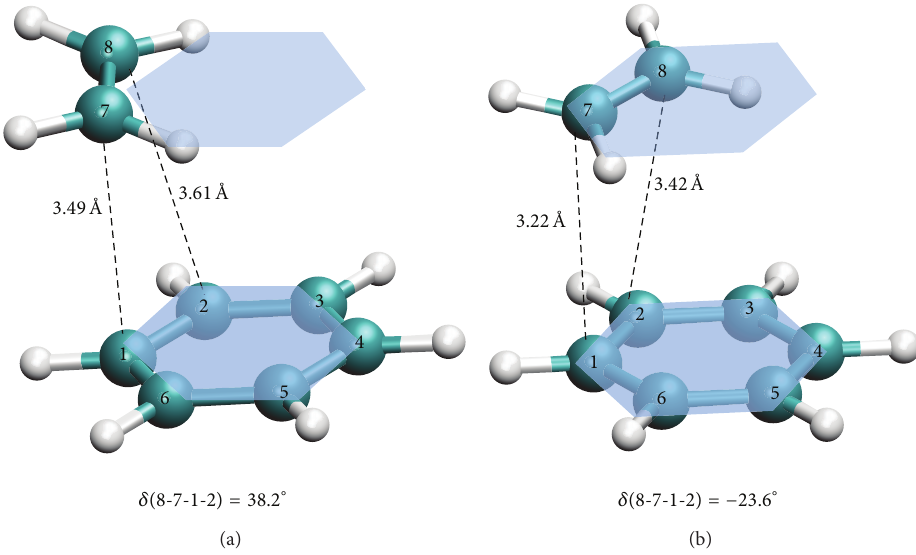
Figure 1: (a) The equilibrated Geometry I and (b) equilibrated Geometry II of the benzene plus ethylene molecule with atomic labeling. Shadows herein indicate hypothetical hexagonal prism space of upward projection of benzene